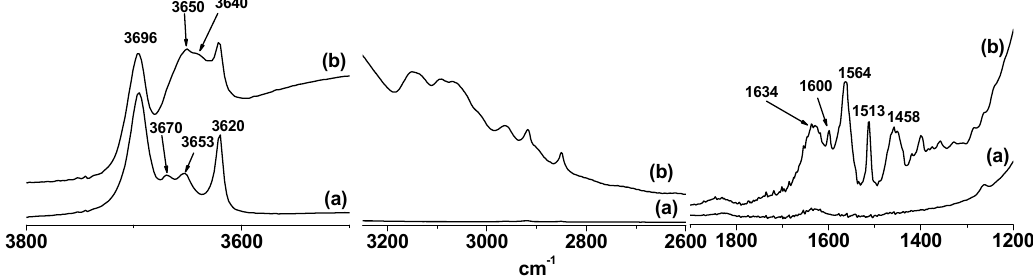
Figure 4. FTIR Spectra of ( a ) kaolinite and ( b ) K-NI.